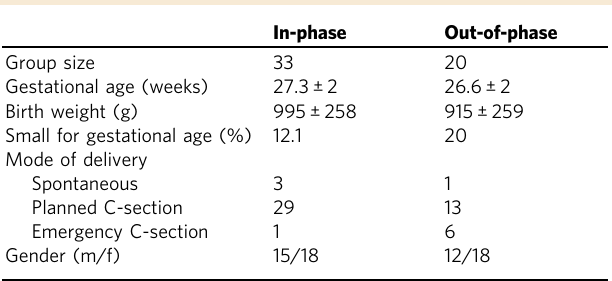
Table 1 Cohort description.